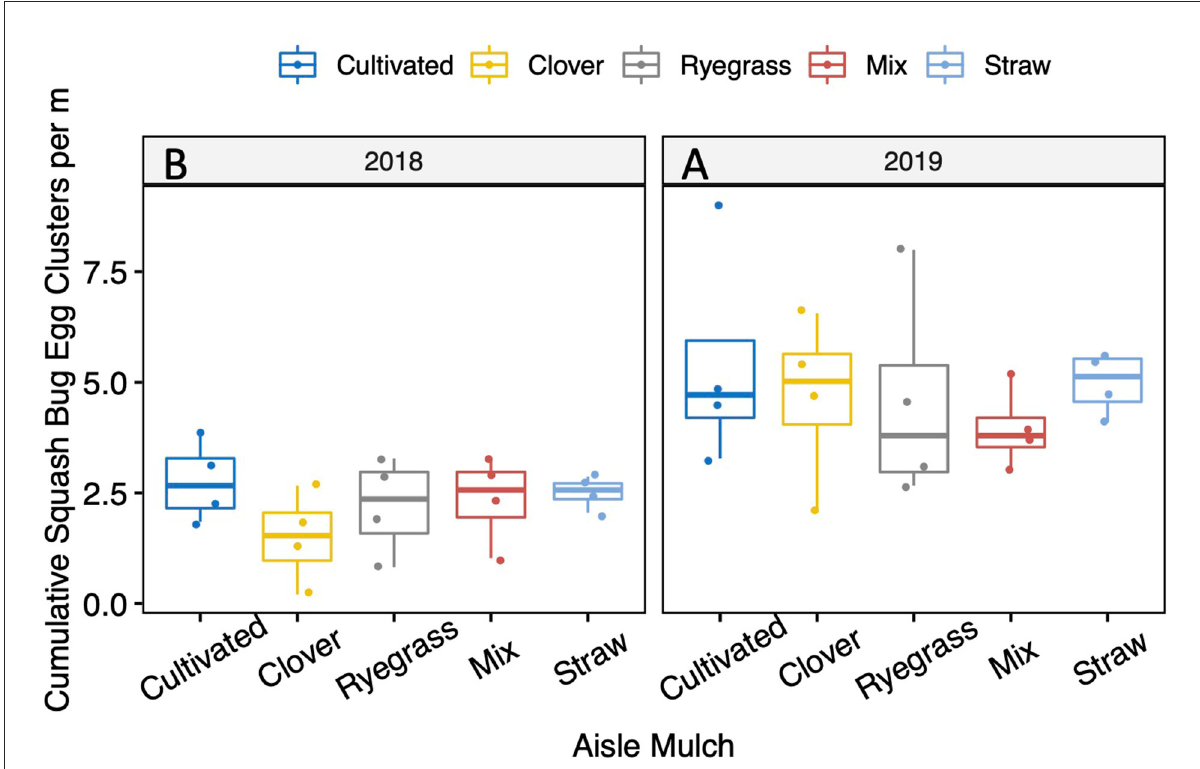
FIGURE3 Cumulative squash bug egg clusters m − 1 on organic zucchini plants grown using cover crop living mulches, 2018 and 2019.